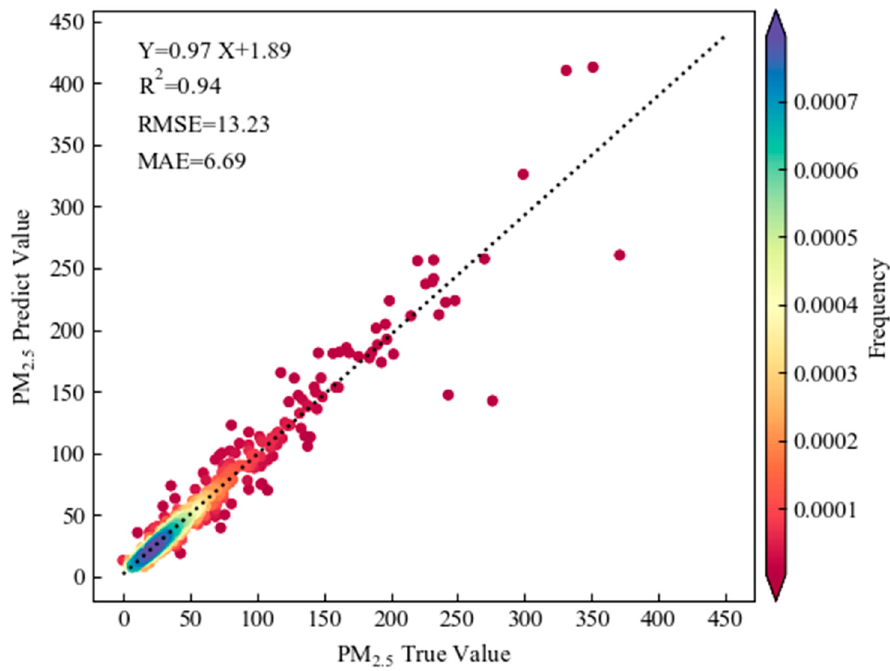
Figure 3. Prediction results.